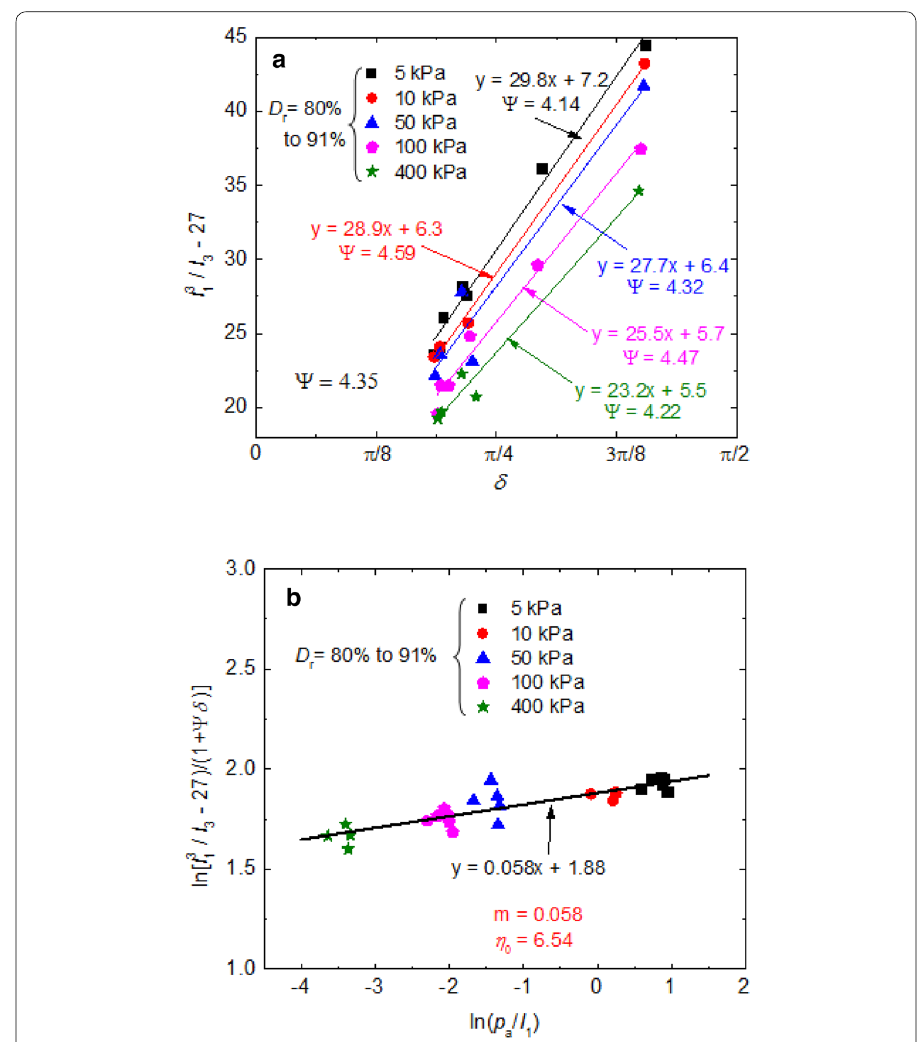
Fig. 11 Model calibration for general